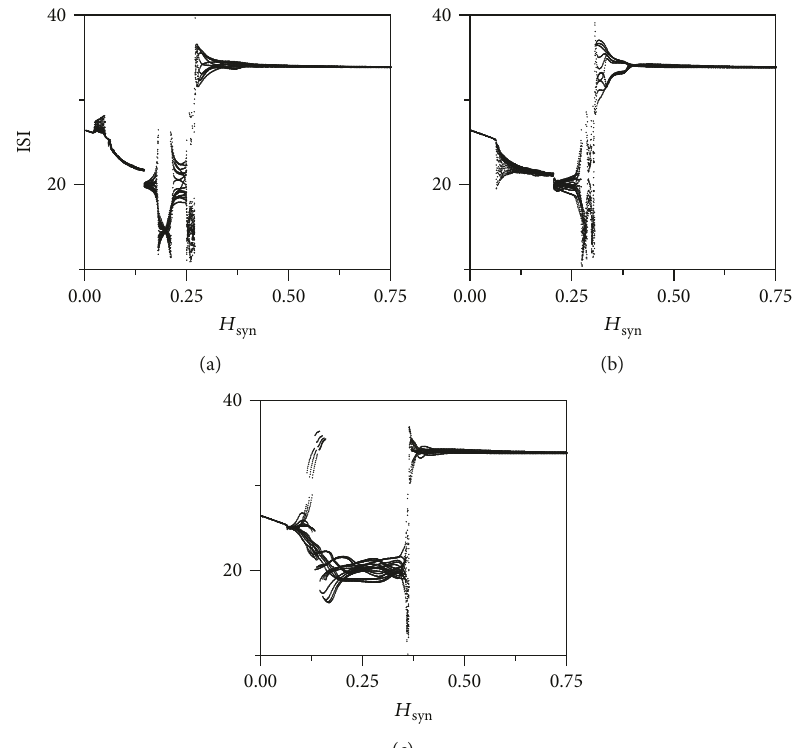
ff erent coupling strengths. The time lag τ = 50 , (a) C = 0 1 ; (b) C = 0 5 ; syn for di